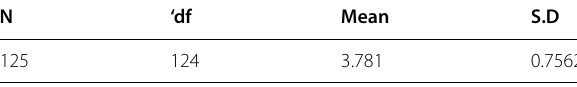
Table 1 Table showing the